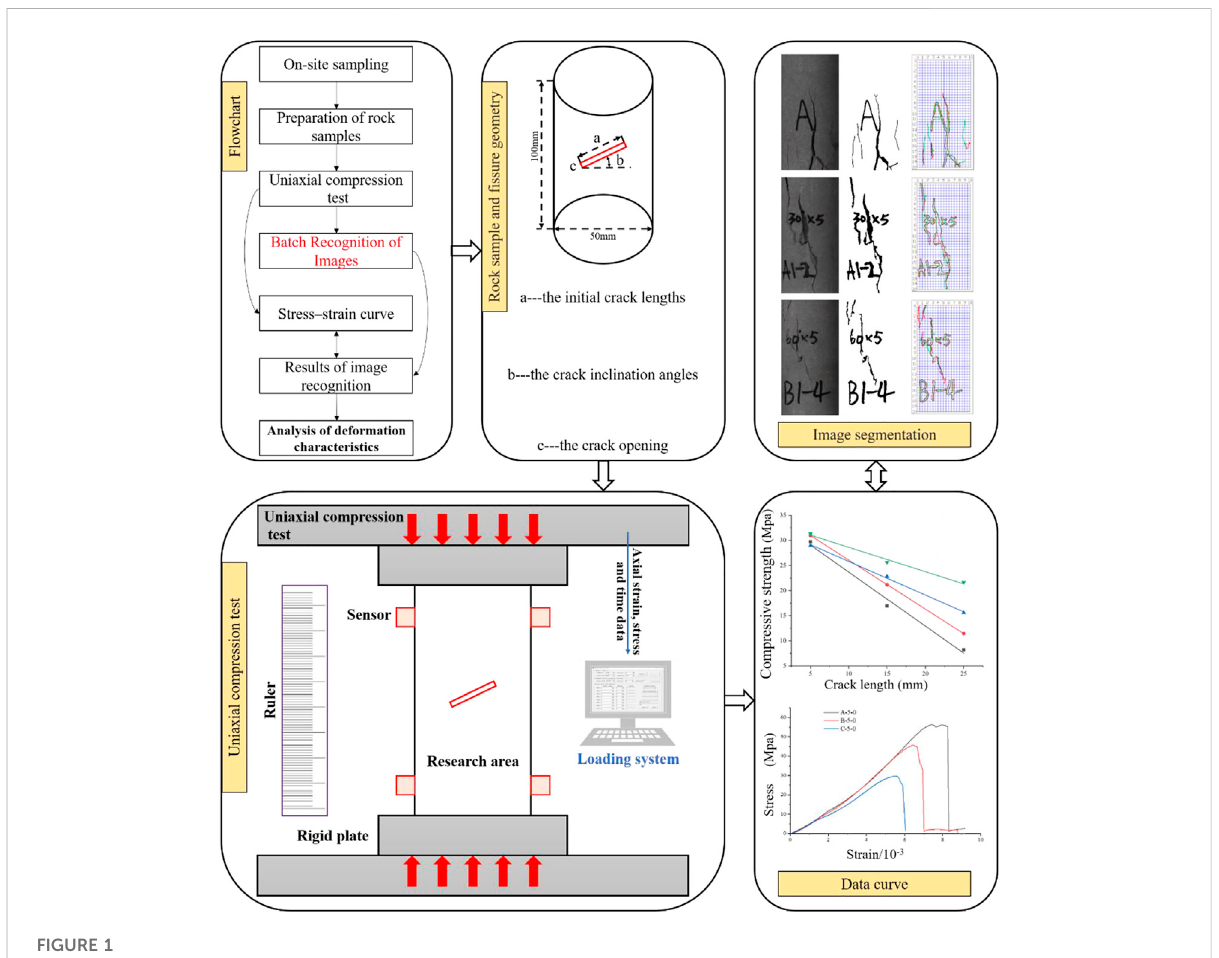
FIGURE 1 Overall fl ow chart of the